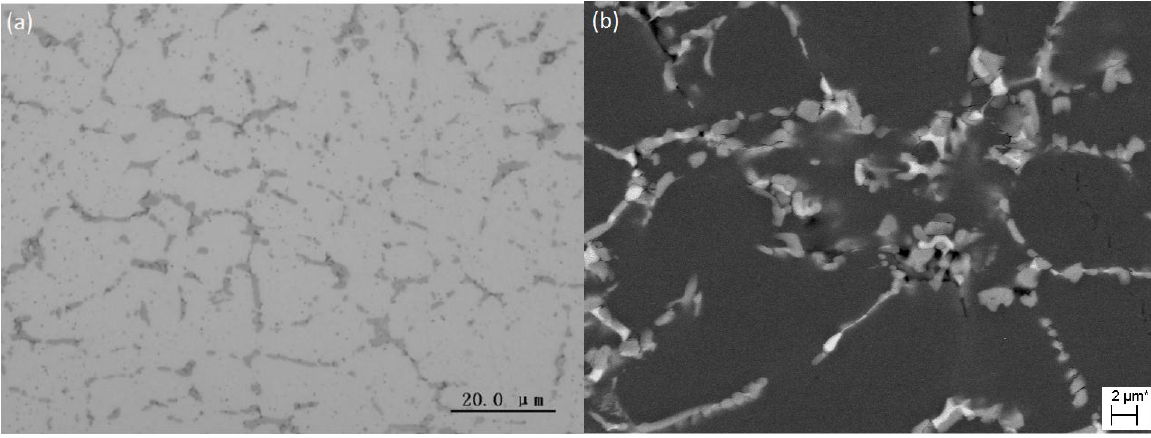
Figure 11. As-cast microstructures of the Sample WC: ( a ) OM image; ( b ) SEM backscatted electron image.